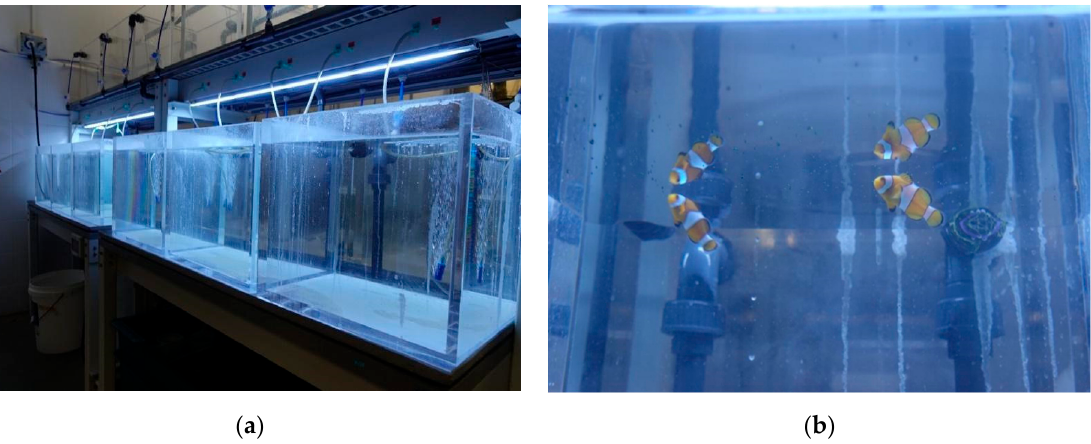
Figure 2. ( a ) Empty fish tanks in preparation; ( b ) clownfish feeding on the experimental